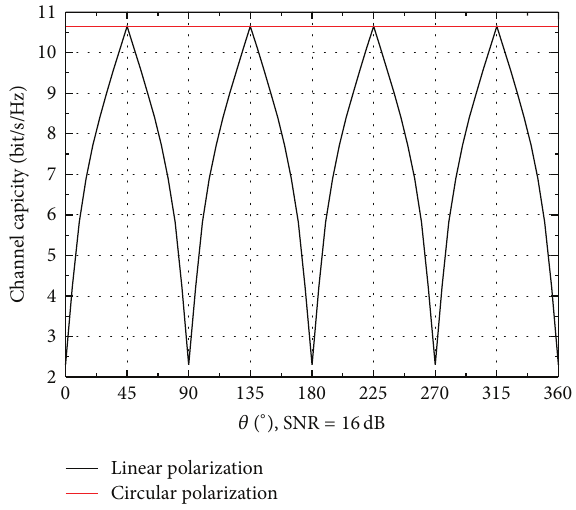
Figure 8: Comparison of MIMO channel capacity between linear polarized antenna and circular polarized antenna.